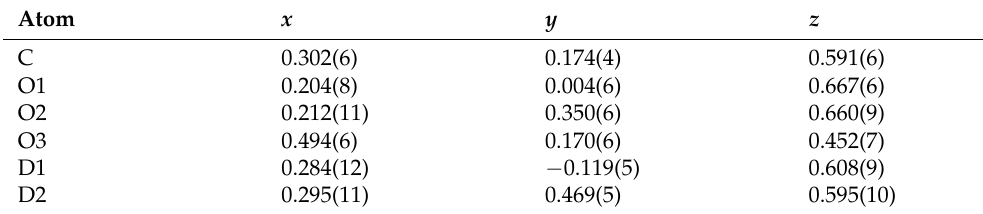
Table A2. Neutron-refined spatial parameters for deuterated carbonic acid at 1.85 GPa with all atoms on Wyckoff position 4 e ; the isotropic displacement parameters (Å 2 ) were set to 0.040 for C, 0.056 for O, and 0.082 for D; see also text.